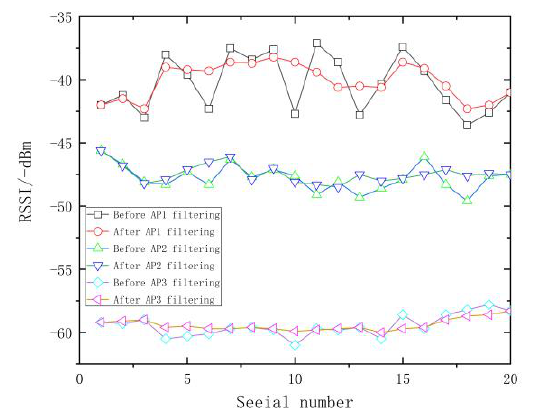
Figure 3. Comparison of fingerprint signal before and after filtering .